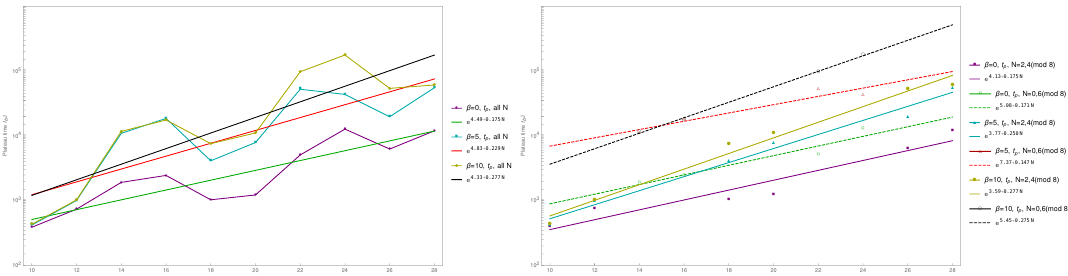
Figure 8 . The plateau time t p for supersymmetric SYK model. We choose three di(cid:11)erent tem- peratures and evaluate the plateau time with respect to N , and we use the exponential function to (cid:12)t t p ( N ). In the left (cid:12)gure we use all N s, while in the right (cid:12)gure we separately (cid:12)t two di(cid:11)erent random matrix